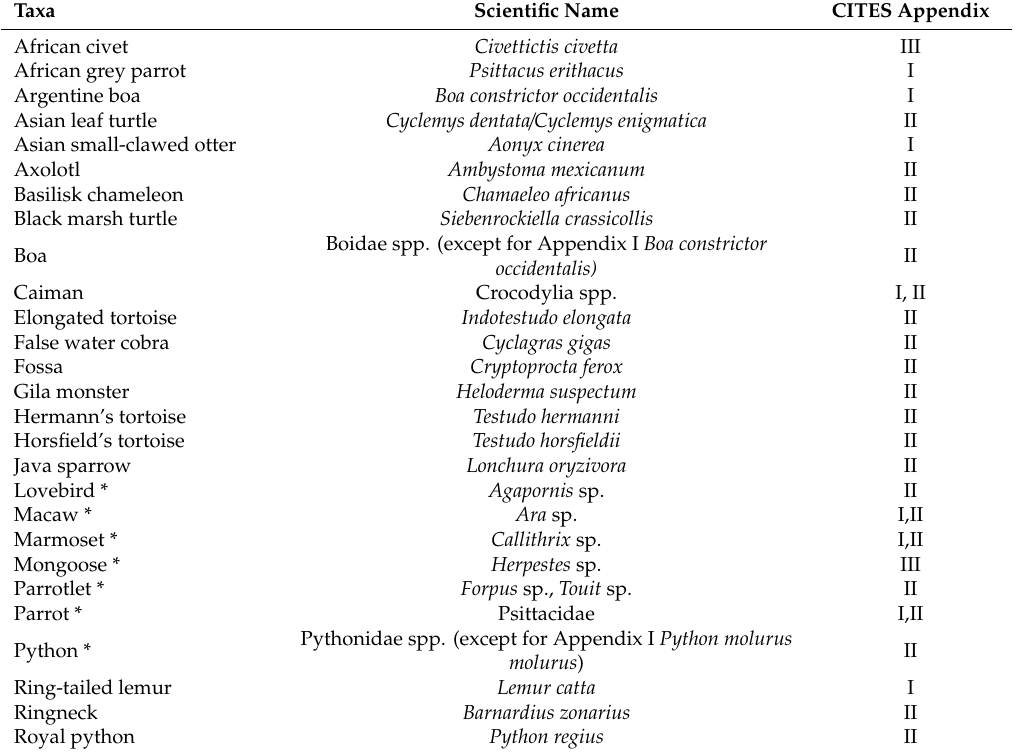
Table A6. Descriptive terms listed on licences relating to specific species listed on CITES Appendices